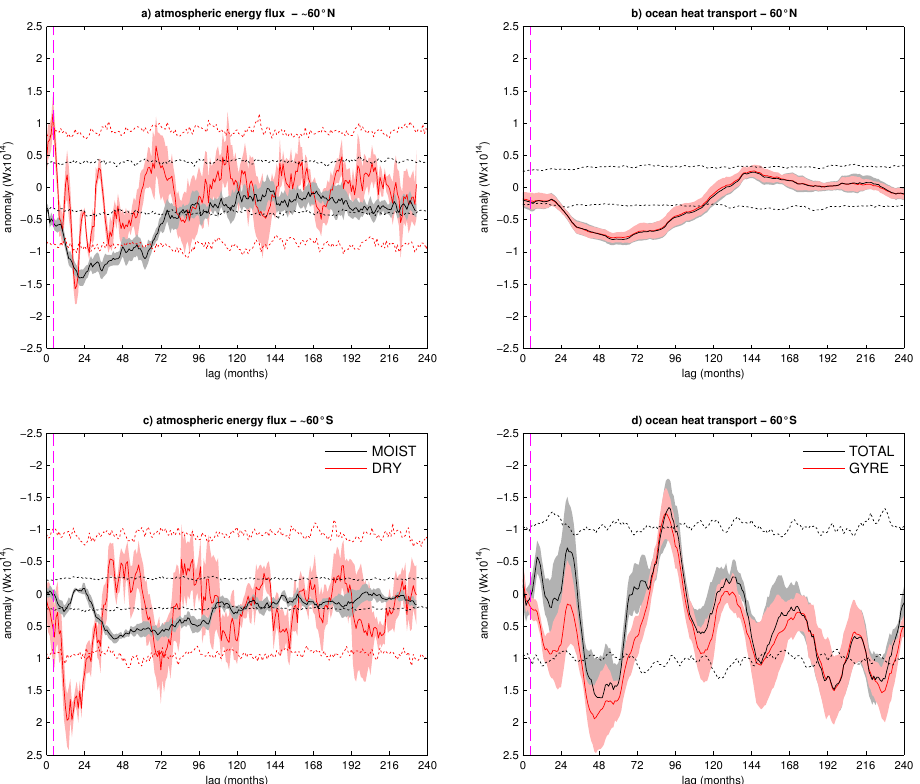
Figure 8. Ensemble-mean simulated anomalies of zonally integrated atmospheric energy transport at ∼ 60 ◦ N (a) and ∼ 60 ◦ S (c) , and oceanic heat transport by advection at 60 ◦ N (b) and at 60 ◦ S (d) for the SUPER1 ensemble. Lines and shading represent the mean anomaly and the standard error of the mean respectively. Dashed lines indicate the internal variability range ( n = 5; see methods). Internal variability ranges for the gyre component of ocean heat transport are not shown, since they are barely distinguishable from that of the total transport. The dashed vertical magenta line indicates the approximate start of the eruptions. Lag(0) corresponds to January of the eruption year. Anomalies are smoothed with a 13-month centered moving average. Positive values correspond to northward transport anomalies ( y axis is inverted in panels (c) and (d) ) to ease the comparison of poleward transports in the two